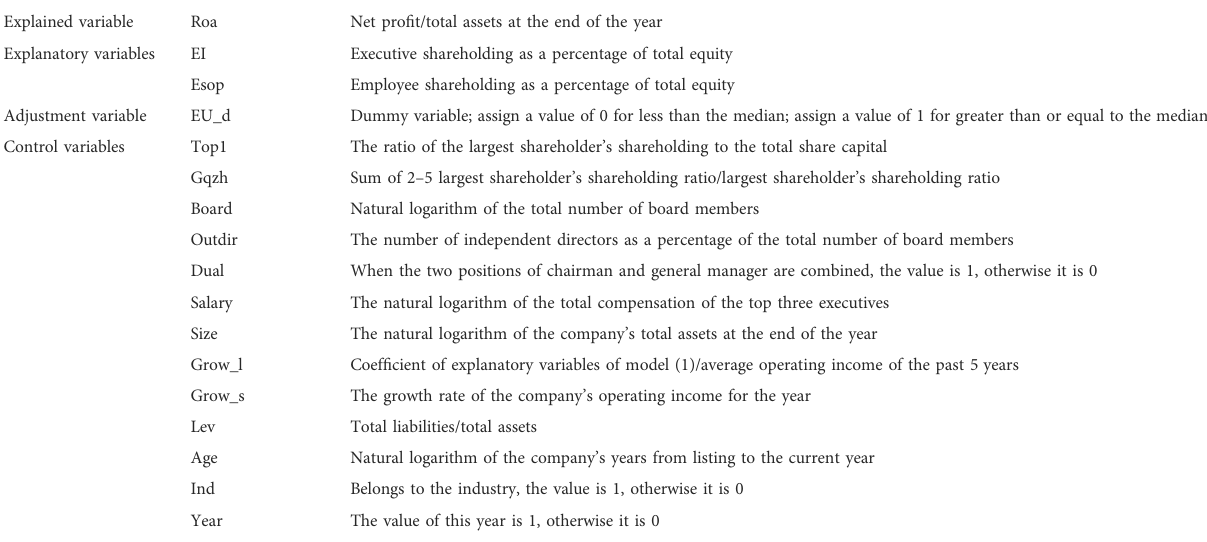
TABLE 1 Variable de fi